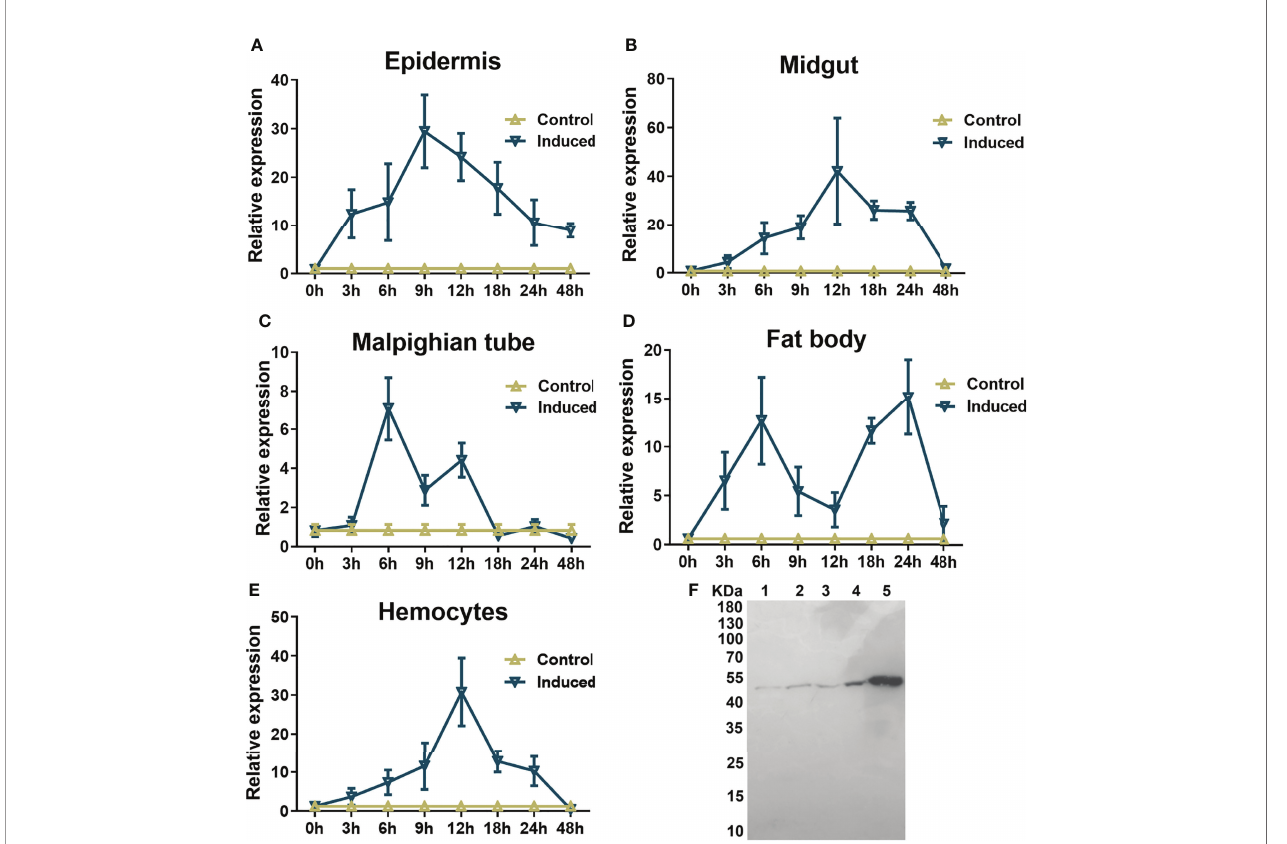
FIGURE 2 | Expression pro fi les of hemolin in A. pernyi larvae. Tissue distribution analysis of Ap -hemolin mRNA in response to immune challenge was detected at different immune challenge times (0, 3, 6, 9, 12, 18, 24 and 48 hr). Tissues involved in the experiment were epidermis (A) , midgut (B) , Malpighian tube (C) , fat body (D) and hemocytes (E) . Each tissue was collected at different times from the samples ( fi ve individuals per time point) injected with insect saline (Control) or the ones immune challenged with the mixture of S. aureus, E. coli and C. albicans (Induced). Each bar represents the mean ± SD (N=3). (F) Changes in hemolin protein levels in cell-free plasma upon microbe injection. Samples were collected before injection (NT) or 12 h after challenge with microbe injection. Lane 1: nontreated 5 th instar larvae plasma (NT); Lane 2: larvae plasma stimulated by S. aureus ; Lane 3: larvae plasma stimulated by C. albicans ; Lane 4: larvae plasma stimulated by E. coli ; Lane 5: recombinant His 6 - Ap -hemolin (2.25 m g, a marker to indicate the migration of endogenous hemolin in hemolymph). All lanes were detected by western blotting assay using